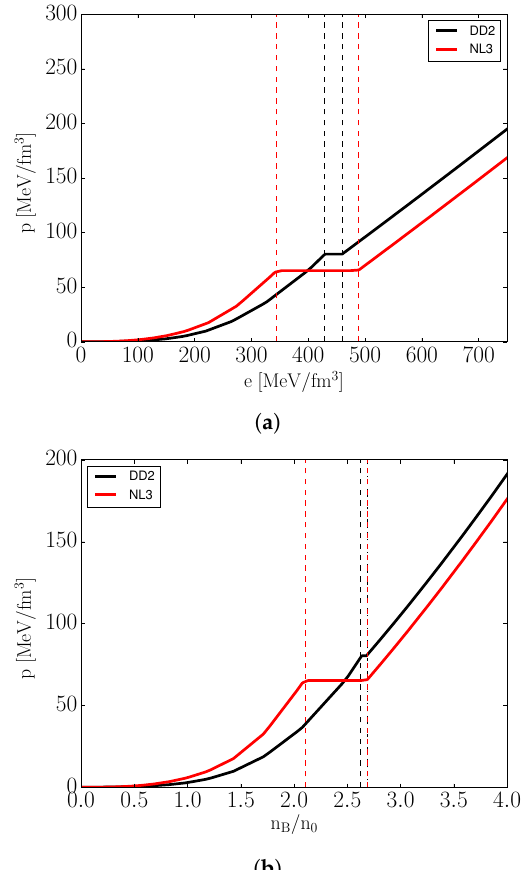
Figure 5. Pressure as a function of energy density (a) and baryon density (b) for cold dense matter in β -equilibrium modeled using vBag ( B 1/4 χ = 152.7 MeV, K v = 6 EoS. Dashed lines highlight mixed phase regions.